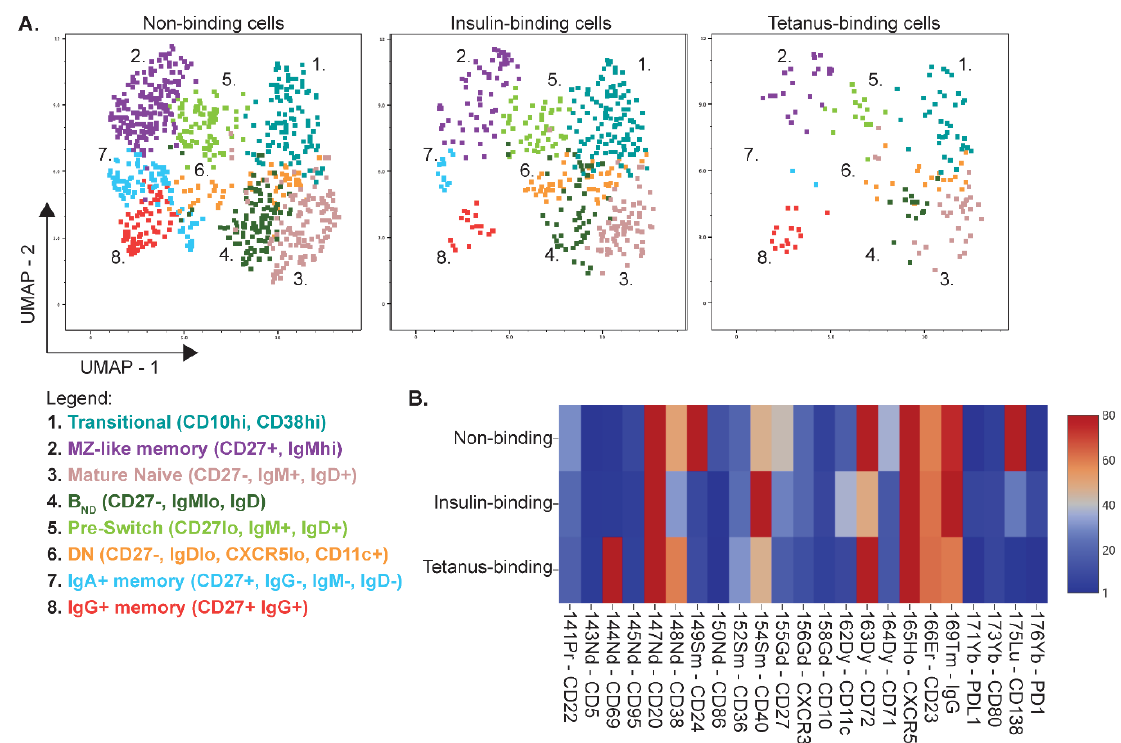
Figure 4. Representative UMAP projections of various B cell subpopulations within the insulin, tetanus, and non-binding B cells demonstrate unique B cell compositions within each antigen-binding B cell subset. ( A ) Insulin-binding B cells can be found in all major B cell subpopulations, with increased frequency in the transitional and naïve (CD27-) subpopulations (populations 1, 3, 4, and 6). Tetanus-binding B cells are more enriched in the memory subpopulations (populations 2, 8) with few cells in the anergic subset (population 4). UMAP projections were generated using the unsupervised clustering algorithm, PhenoGraph, using the following markers: CD27, CD38, CD10, IgM, IgD, IgG, CXCR5, CD11c, and CD86. Antigen-binding populations were manually gated. ( B ) Representative heatmap of expression of various cell surface markers expressed on insulin, tetanus, and non-binding B cells. Colors represent raw mean metal intensities (MMI). Heatmap was generated using